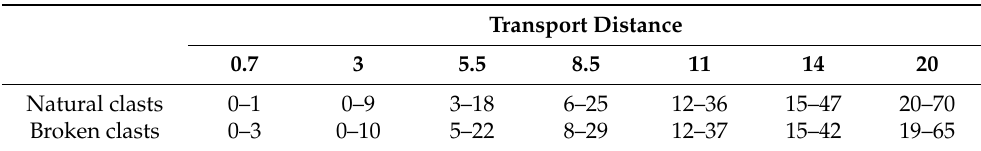
Table 3. Density ranges (marks cm − 2 ) in relation to the oscillatory transport distance separated into naturally shaped and intentionally broken clast assemblages.